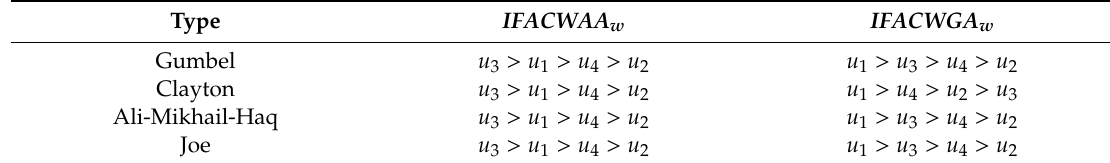
Table 10. Ranking of the alternatives.